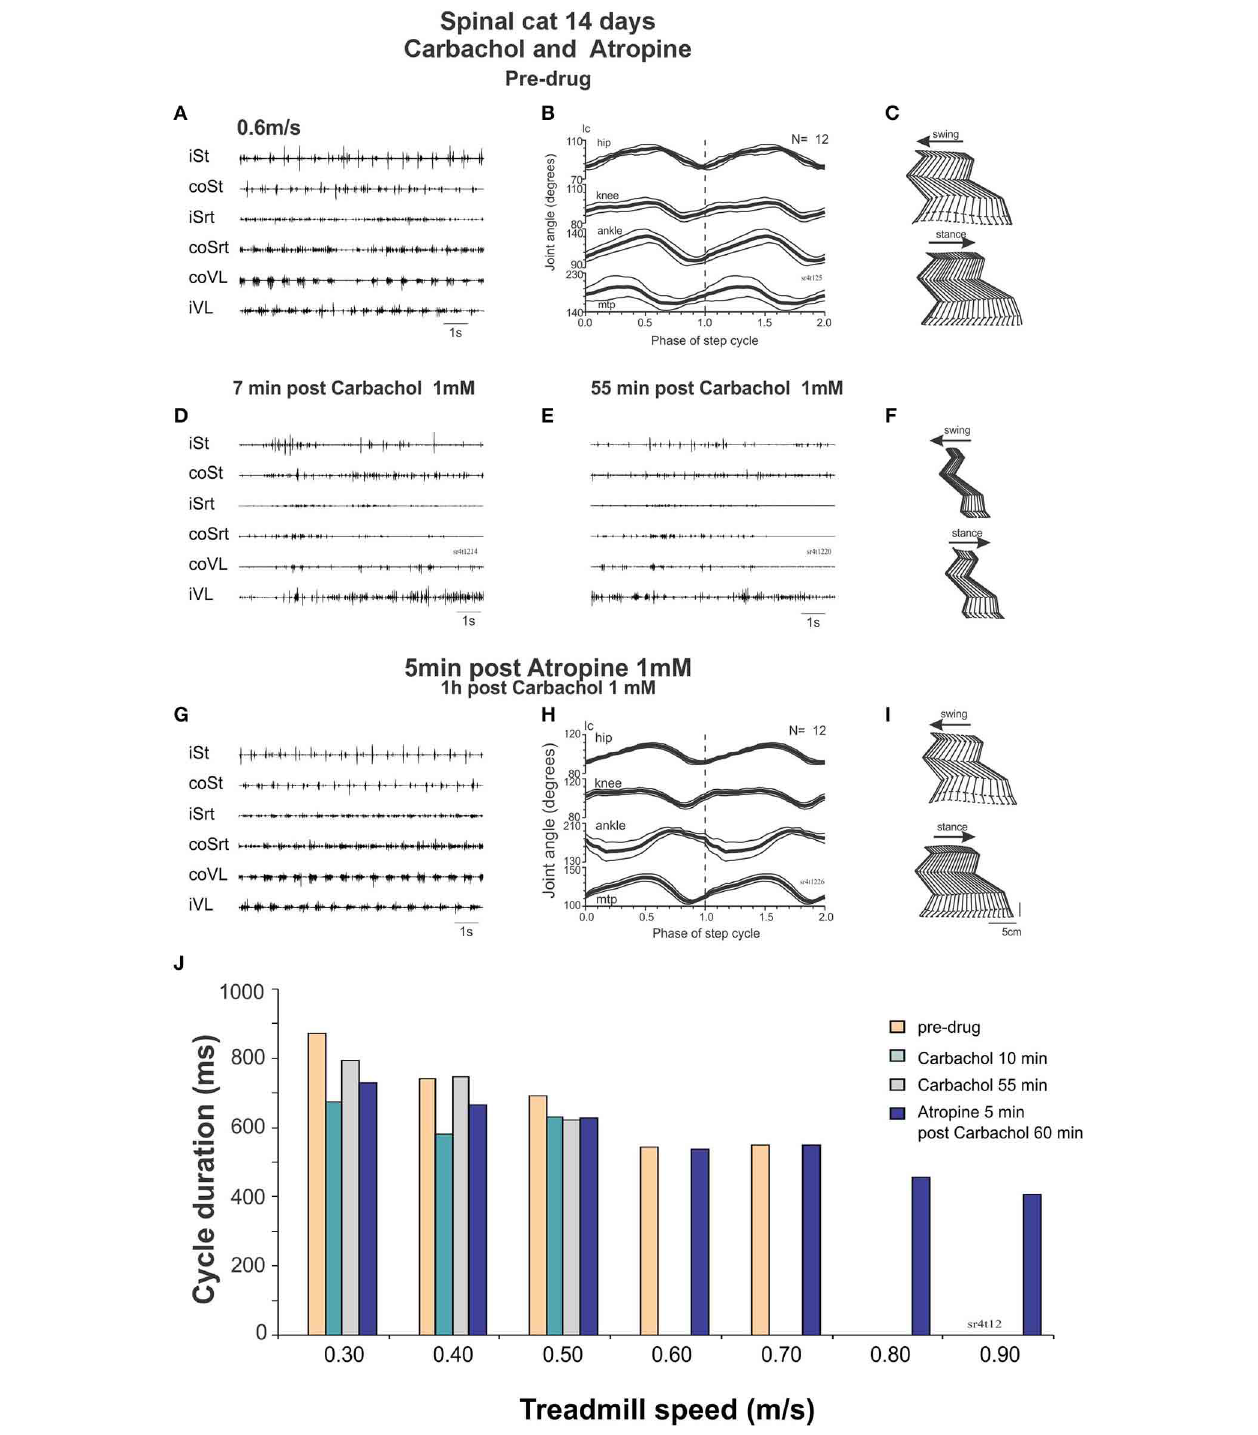
FIGURE 9 | Carbachol disruption of locomotion in spinal cats is reversed by atropine. (A–C) regular stepping movements before drug administration 14 days after the lesion represented by raw EMG traces (A) , averaged ( N = 12 cycles) joint angular displacements (B) and stick figures (C) . (D) Raw EMG recordings after intrathecal carbachol (1mM, 100 μ l) showing deterioration of stepping as soon as 7min post drug administration even with strong perineal stimulation. (E,F) 55min post carbachol, the EMG is still not